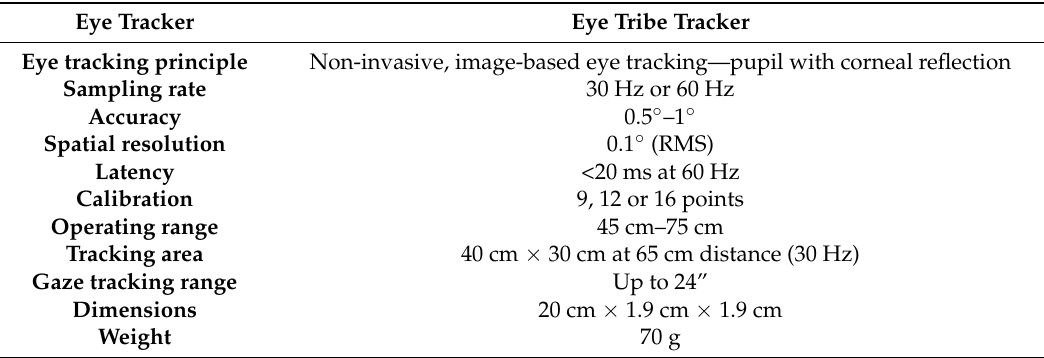
Table 1. Specifications of the Eye Tribe low-cost device (see Reference